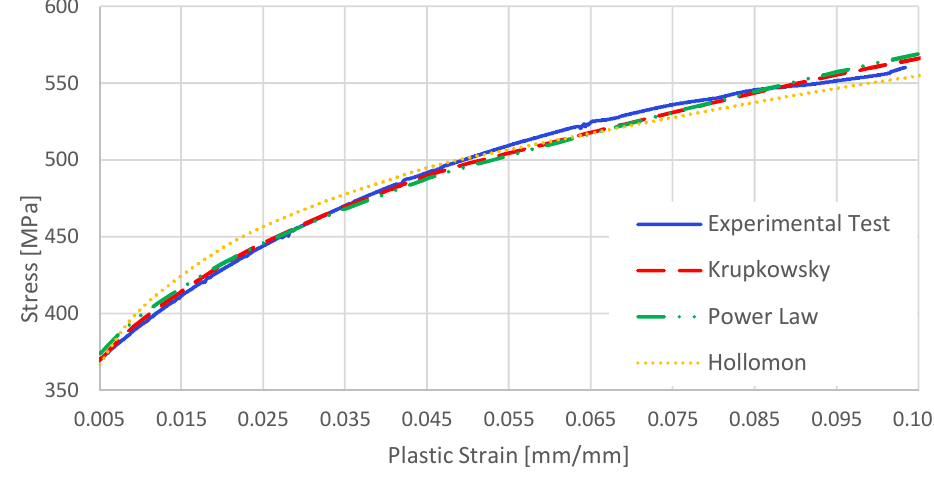
Figure 11. Hardening curves of the material UNS A92024-T3 aluminum alloy according to Krupkowsky, Power Law, and Hollomon criteria.